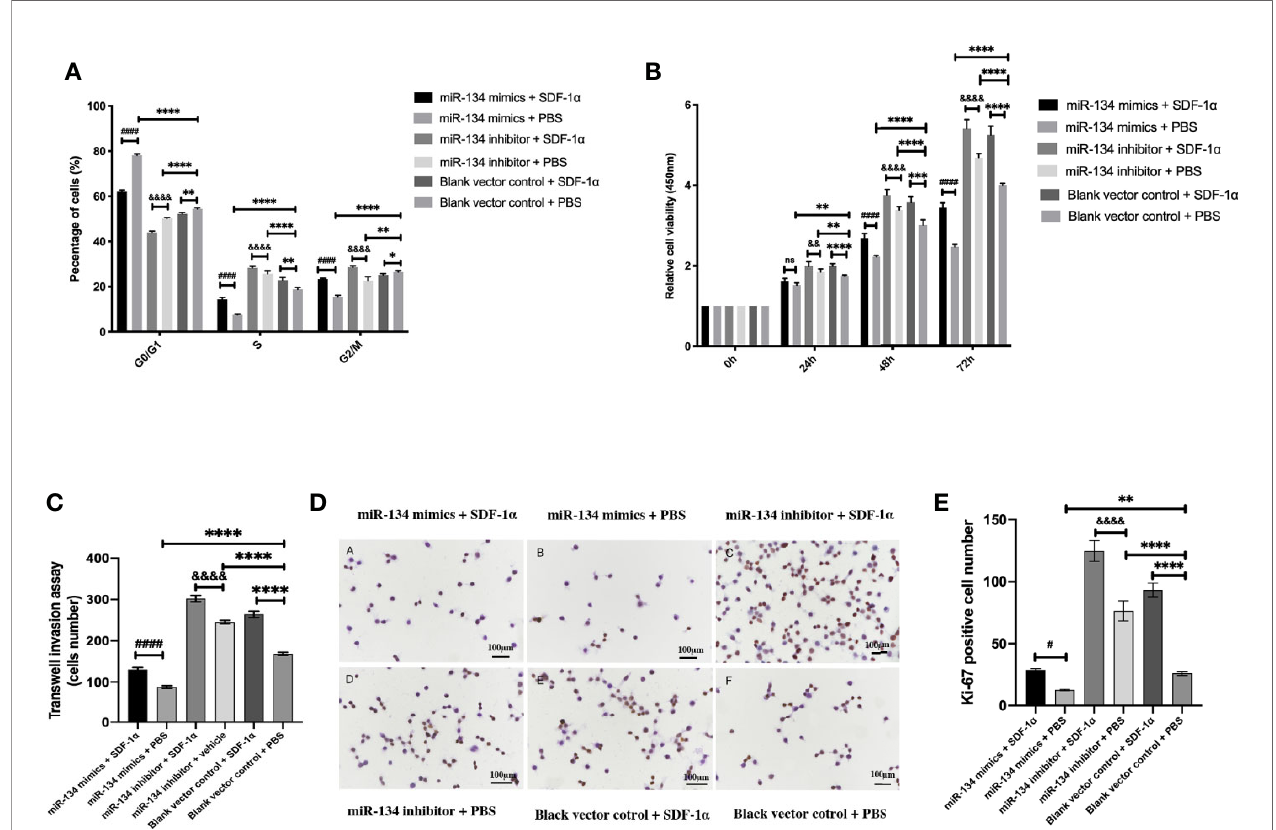
FIGURE 3 | Effects of SDF-1 a /miR-134 on cell cycle transition, proliferation, and viability. MiR-134 mimics or inhibitor was transiently transfected into a T3-1 cells. After 48 h transfection, a T3-1 cells were treated with 20 ng/ml SDF-1 a , equal volume of PBS, and black vector control respectively. (A) Cell cycle distribution using fl ow cytometry. (B) Cell viability using CCK-8 assay. (C) Analysis of cell invasion using transwell assay. (D) Immunohistochemical staining assay of Ki-67. (E) Positive Ki-67 cell was counted manually by Image J. Data were represented as means ± SD (n = 3). #### p < 0.0001 and # p < 0.05 vs. miR-134 mimics + PBS group. &&&& p < 0.0001 and && p < 0.01 vs. miR-134 inhibitor + PBS group. **** p < 0.0001, **p < 0.01 and * p < 0.05 vs. black vector control + PBS